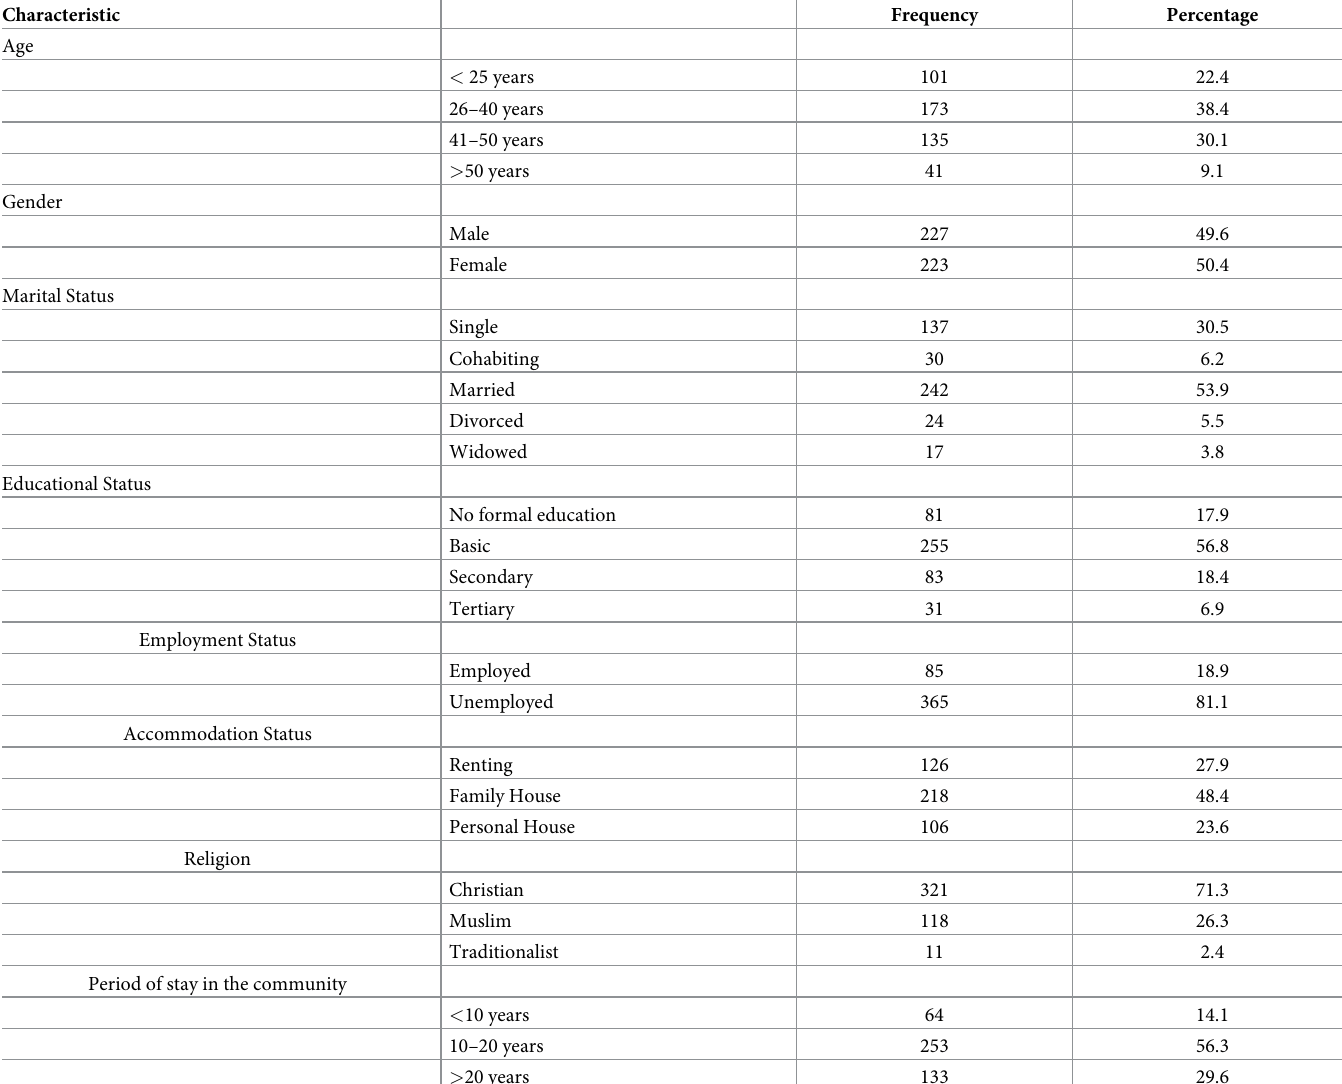
Table 2. Characteristics of the study